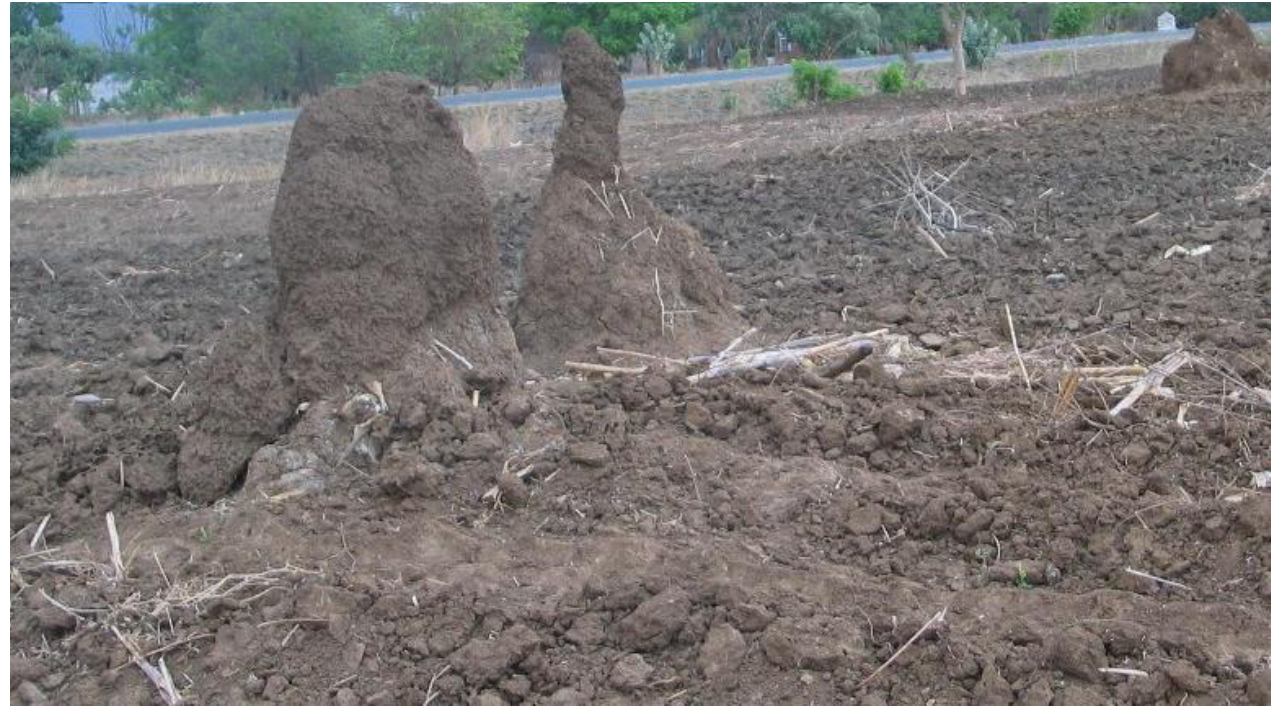
Fig. 3. Farmers’ usually leave termitaria intact when cultivating crop fields. This figure shows live Macrotermes mounds left in a field ready for planting maize in Balaka district of southern